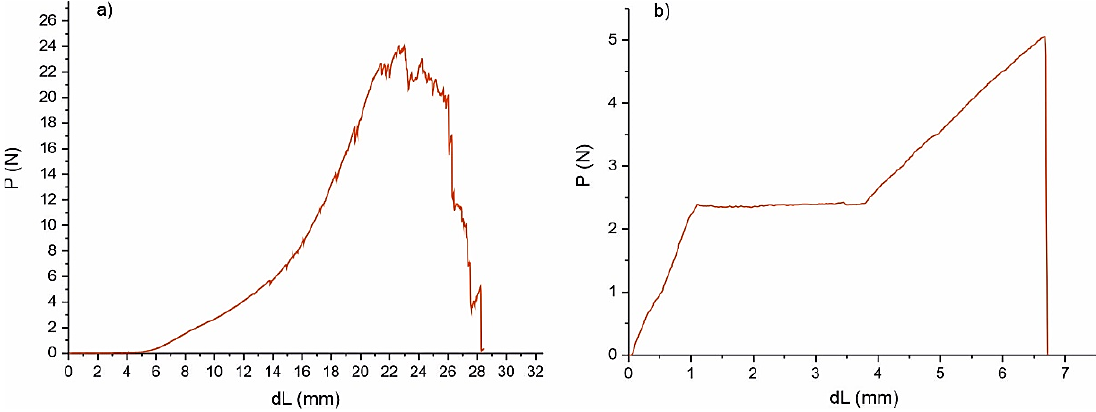
Figure 7. Uniaxial tension to rupture of the knitted TiNi mesh ( a ) and TiNi wire ( b ). Cyclic tensile tests up to 10% and 20% strain, which correspond to 5 and 10 mm elon-